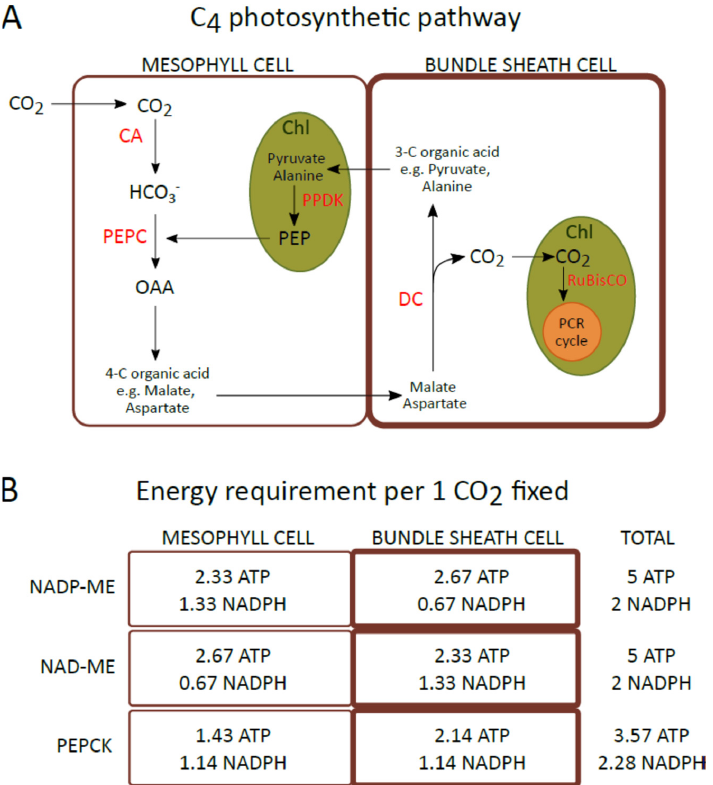
Figure 1. ( A ) Schematic describing the general metabolic pathway of C4 photosynthesis. ( B ) The requirement for ATP and NADPH per fixed CO 2 in mesophyll and bundle sheath cells of plants representing the NADP-ME, NAD-ME, and PEPCK subtypes of C4 photosynthesis.ATP and NADPH requirements estimated by Edwards and Voznesenskaya [9]. CA: carbonic anhydrase; Chl: